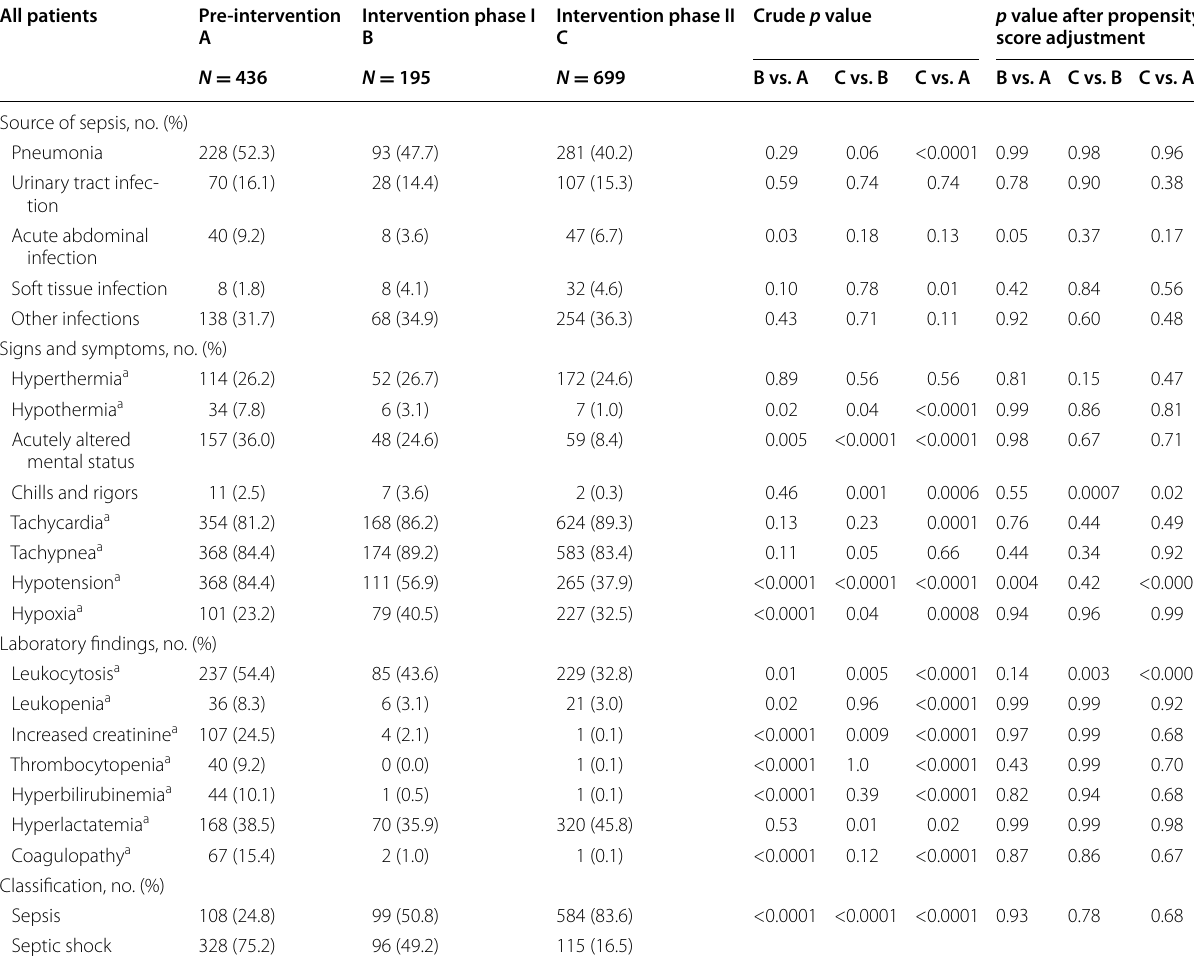
Table 1 Baseline characteristics of patients with sepsis and septic shock on presentation in the three study phases: